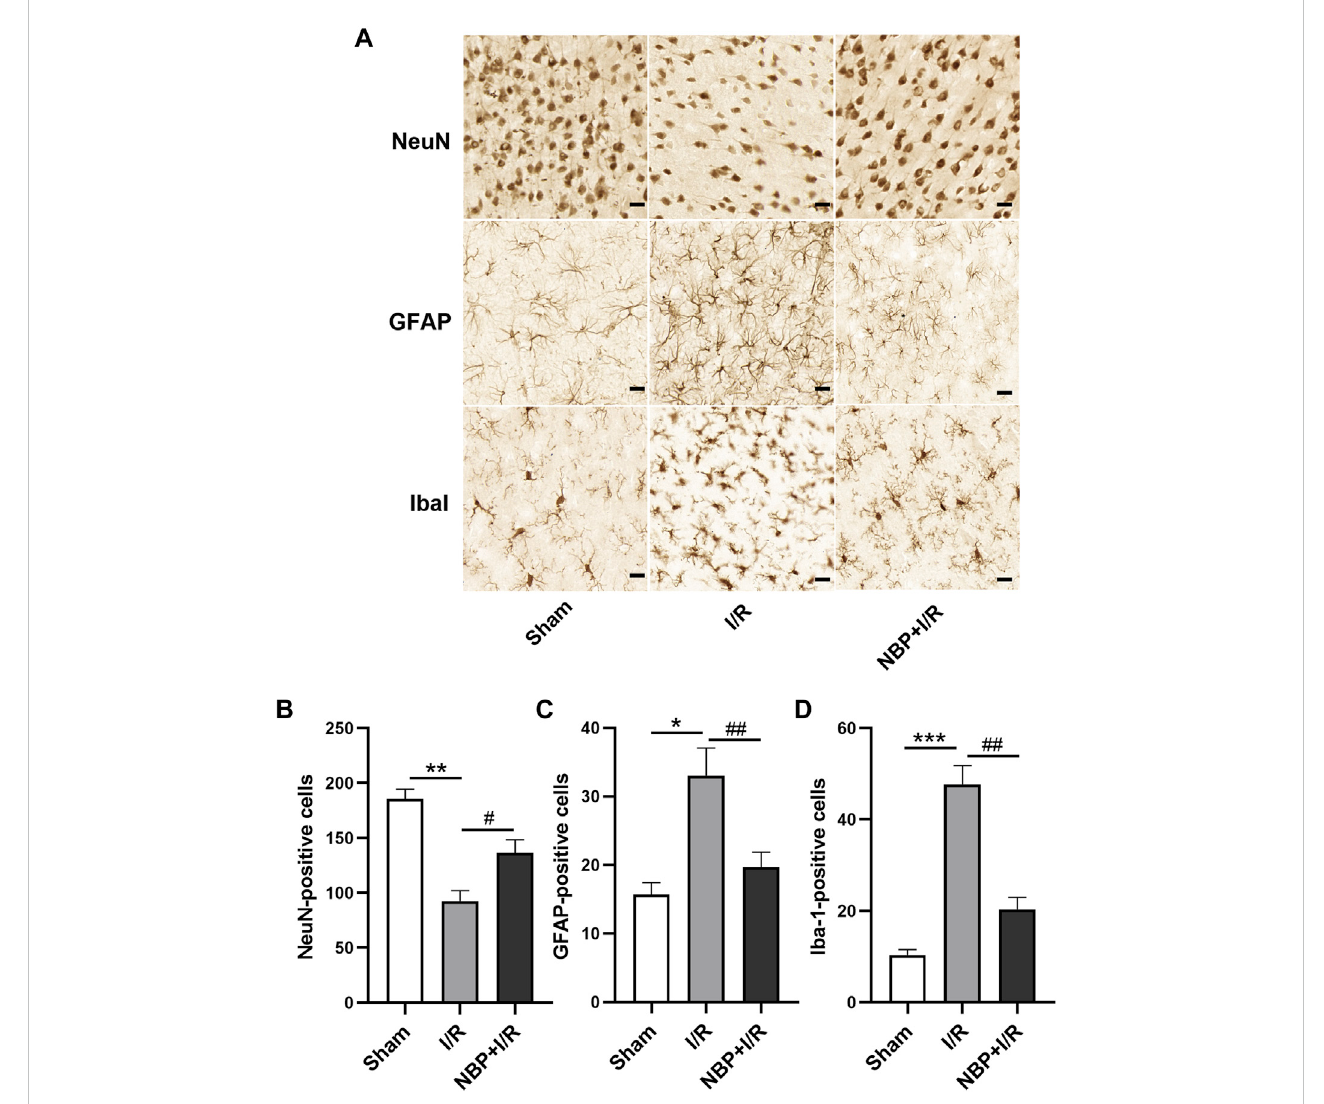
Effects of NBP on nerve cells in the ischemic penumbra in I/R rats. (A) NeuN, GFAP and Iba1 staining by immunochemistry (scale bar = 20 μ m). NBP signi fi cantly increased NeuN-positive cells (B) and decreased GFAP-positive cells (C) and Iba1-positive cells (D) , suggesting that NBP could preserve the viability of neuronsand protect microgliaand astrocytes againstoveractivation inI/R rats. Data areexpressedas themean± SEM (n= 3)and wereanalyzed by one-way ANOVA ( post hoc analysis: Tukey ’ s post hoc analysis test). ** ( p < .01) represents signi fi cance compared to the sham group. # ( p < .05) represents signi fi cance compared to the I/R group ( p < .01). NBP dose: NBP + I/R, 9